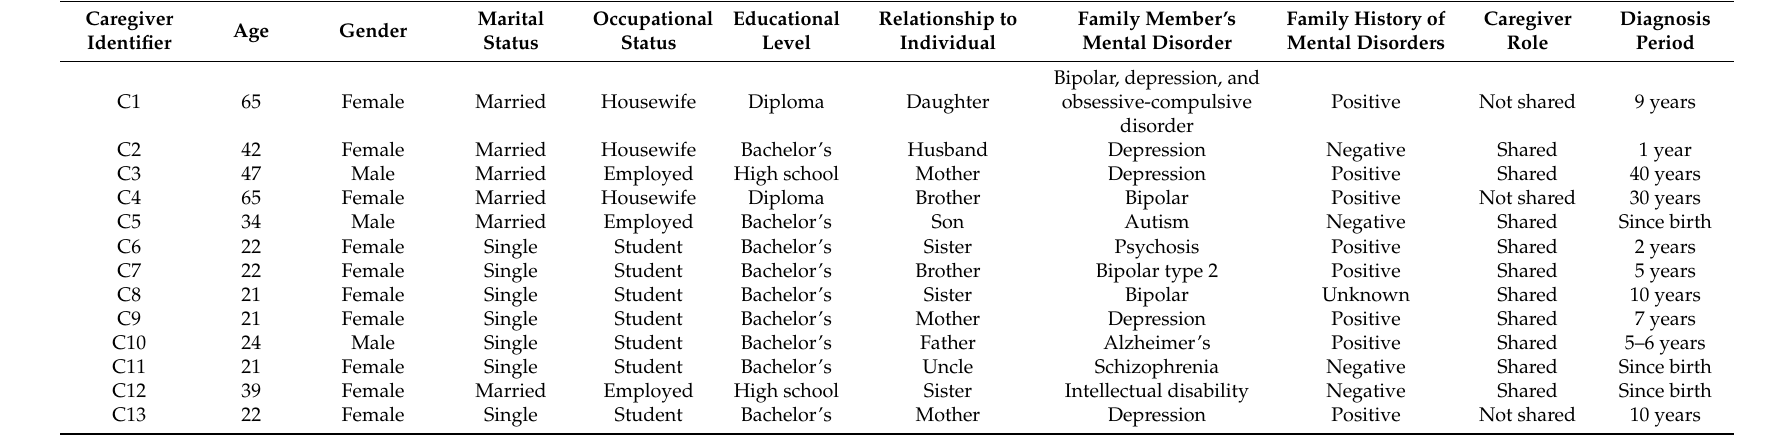
Table 1. Study participants’